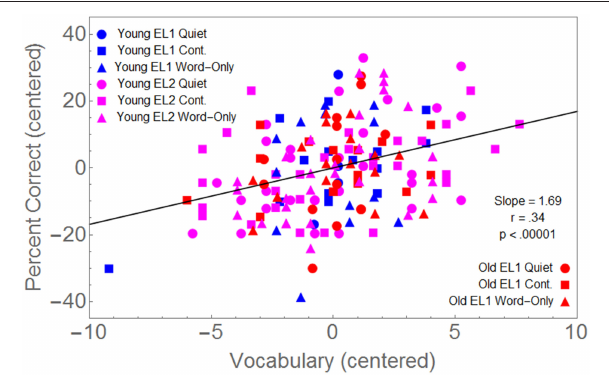
FIGURE 5 | Percent correct word recall, centered in each combination of three Groups (Y-EL1, Y-EL2, O-EL1) × 3 Masker Conditions (Quiet, Continuous Babble, Word-Only Babble), is plotted as a function of the vocabulary scores also centered in each of these nine